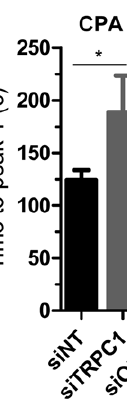
Figure 6. Effect of TRPC1 and ORAI1 silencing on Ca 2 + influx pathways in MDA-MB-468 breast cancer cells. Non-stimulated Ca 2 + influx was assessed in MDA-MB-468 breast cancer cells with ORAI1 silencing (siORAI1) or TRPC1 silencing (siTRPC1); A ) average cytosolic Ca 2 + response, B ) peak relative Ca 2 + influx (peak 2) and C ) ratio of Ca 2 + influx amplitude (peak 2) divided by AUC (t=0-705 s). The role of ORAI1 and TRPC1 in agonist- stimulated Ca 2 + entry, mediated by 100 m M ATP ( D–F ) and 30 nM trypsin ( G–I ), and store-operated Ca 2 + entry with 10 m M CPA ( J–L ) was assessed.